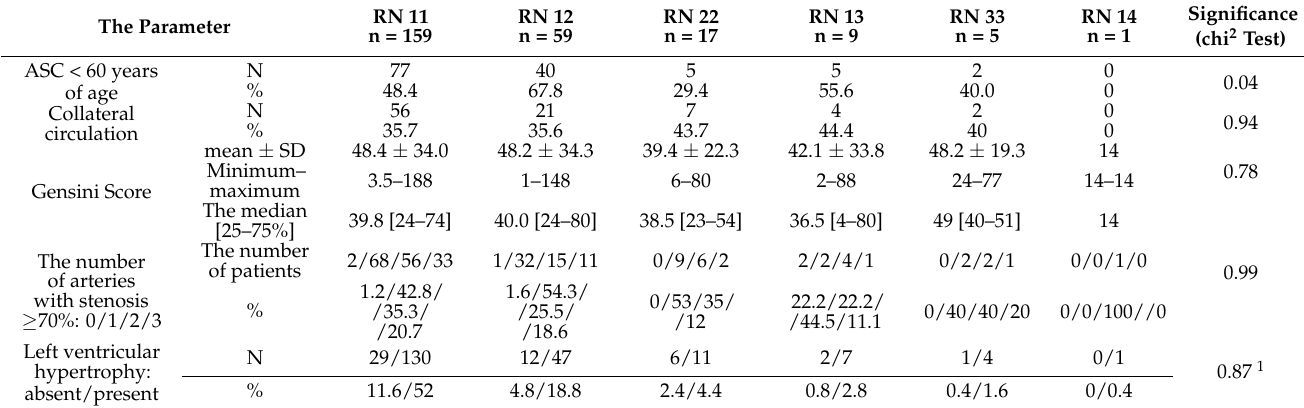
Table 9. The clinical and angiographic parameters according to the variant at locus -RN.